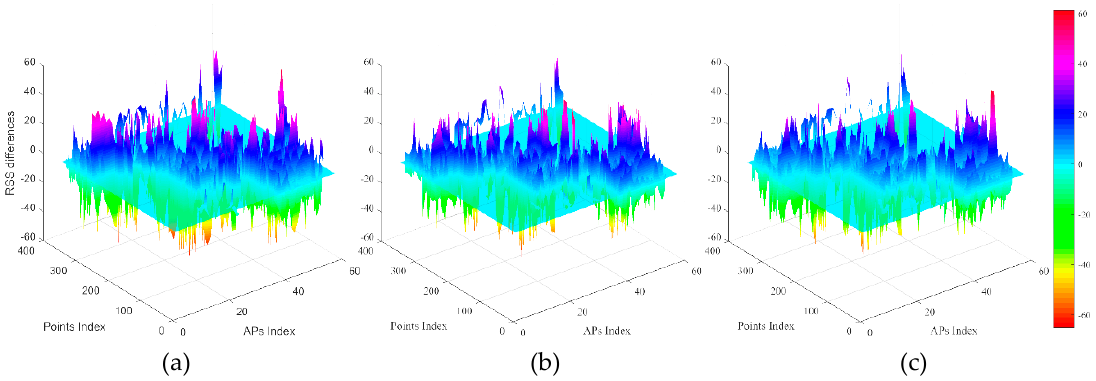
Figure 7. RSS differences between manual radio map and ( a ) IDW Interp_RM, ( b ) Kriging Interp_RM, ( c ) PL Interp_RM constructed based on the sparse RPs with the interval of 10.8 m.